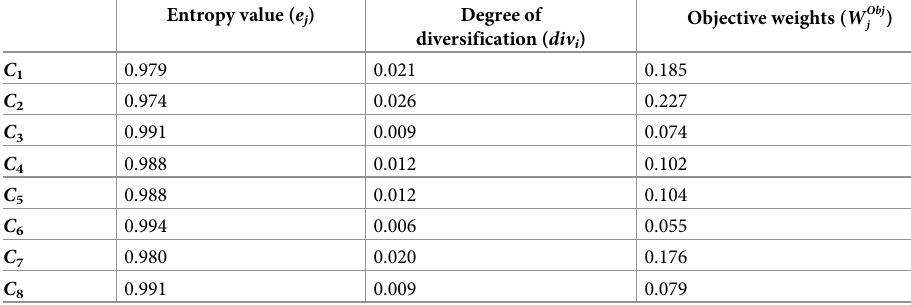
Table 9. Objective weights based on entropy measure.